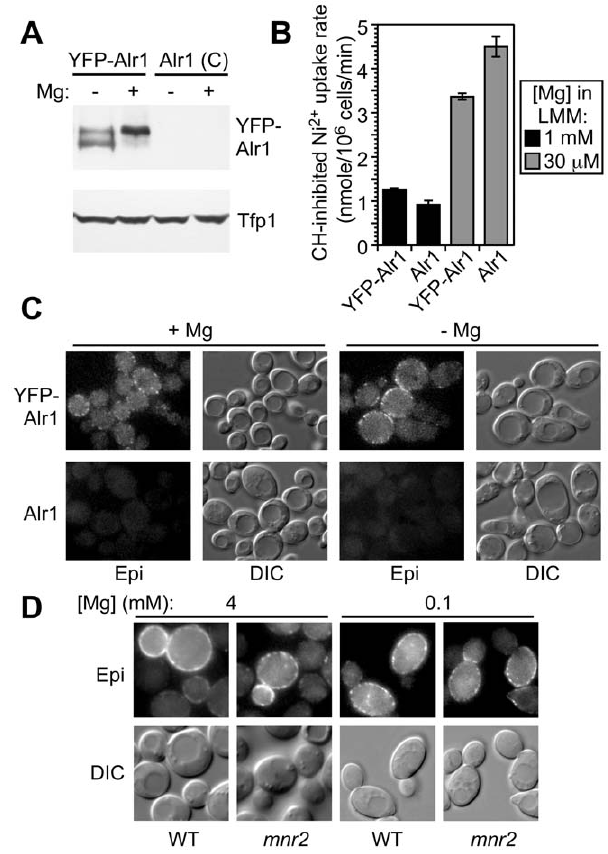
Figure 5. Effect of Mg supply on Alr1 location. ( A ) alr1 strains (NP4) transformed with YCpCit-ALR1 (YFP-Alr1) or YCpALR1 (Alr1) were grown for 16 h in LMM supplemented with 1 m M ( 2 ) or 1 mM ( + ) Mg prior to protein extraction. YFP-Alr1 and Tfp1 proteins were detected by immunoblotting with anti-GFP or anti-Tfp1 antibodies respectively. ( B ) Rate of CH-inhibited Ni 2 + uptake by cells expressing native and YFP- tagged Alr1. Strains described in (A) were grown to log phase in SC medium, washed to remove Mg, and incubated for 6 h in LMM with the indicated Mg concentration. The rate of CH-inhibited Ni 2 + uptake was then determined as described in the legend to Figure 1 . Values are means of four replicates + / 2 1 SEM. ( C ) Strains described in (A) were grown to exponential phase in SC, then transferred to LMM containing 5 m M ( 2 ) or 5 mM ( + ) Mg for 6 hours, and live cells examined by epifluorescence microscopy. YFP fluorescence (Epi) and corresponding differential interference contrast (DIC) images are shown. ( D ) Diploid WT (BY4743) and mnr2 (34913) strains transformed with YCpCit-ALR1 were grown to log phase in SC medium (2 mM Mg), or LMM + 100 m M Mg and examined with epifluorescence microscopy (Epi), or DIC as indicated.